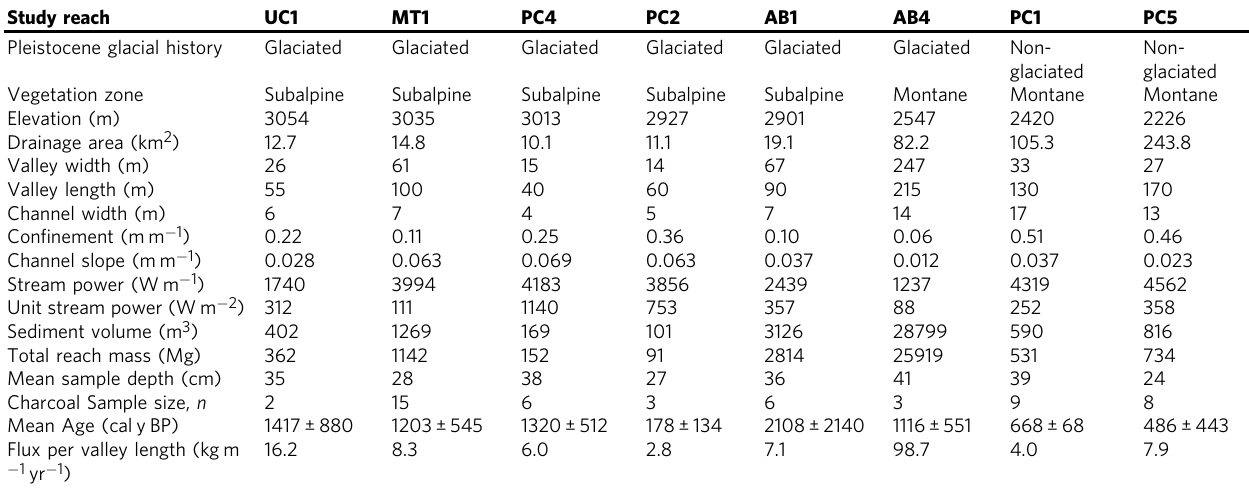
Table 1 Field study site characteristics